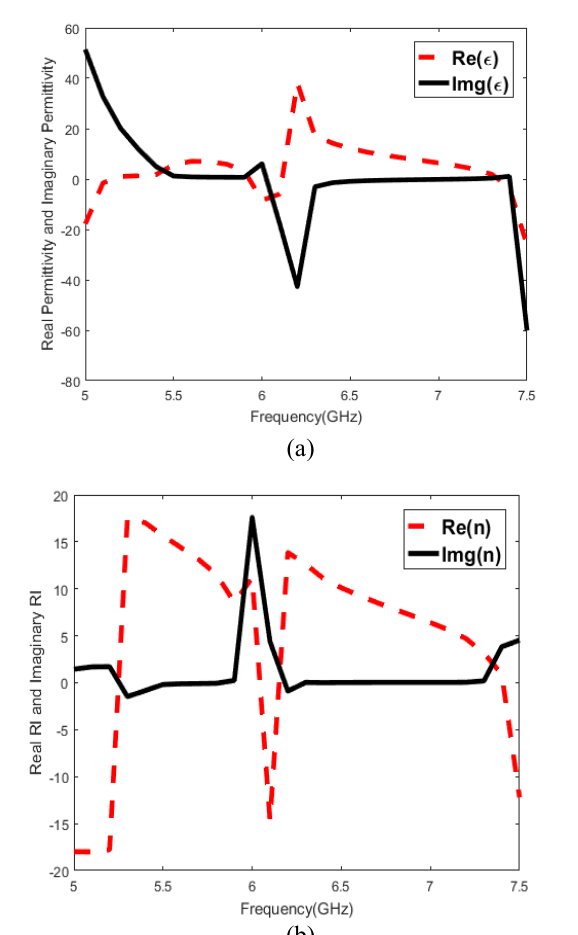
Figure 5. Retrieved (a) permittivity (b) refractive index